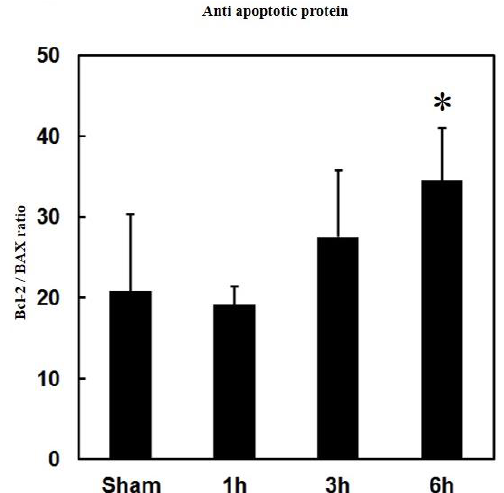
Figure 4. Effects of PPTg DBS on the anti- and pro-apoptotic protein ratio. Illustration of ratio of Bcl-2/BAX expressions were detected in hippocampal brain tissue at hours 1, 3, and 6-time intervals. Data were presented as mean ± SD ( n = 6). Significant differences between groups were analyzed using one-way ANOVA. * p < 0.05 was considered statistically significant compared with the sham group.